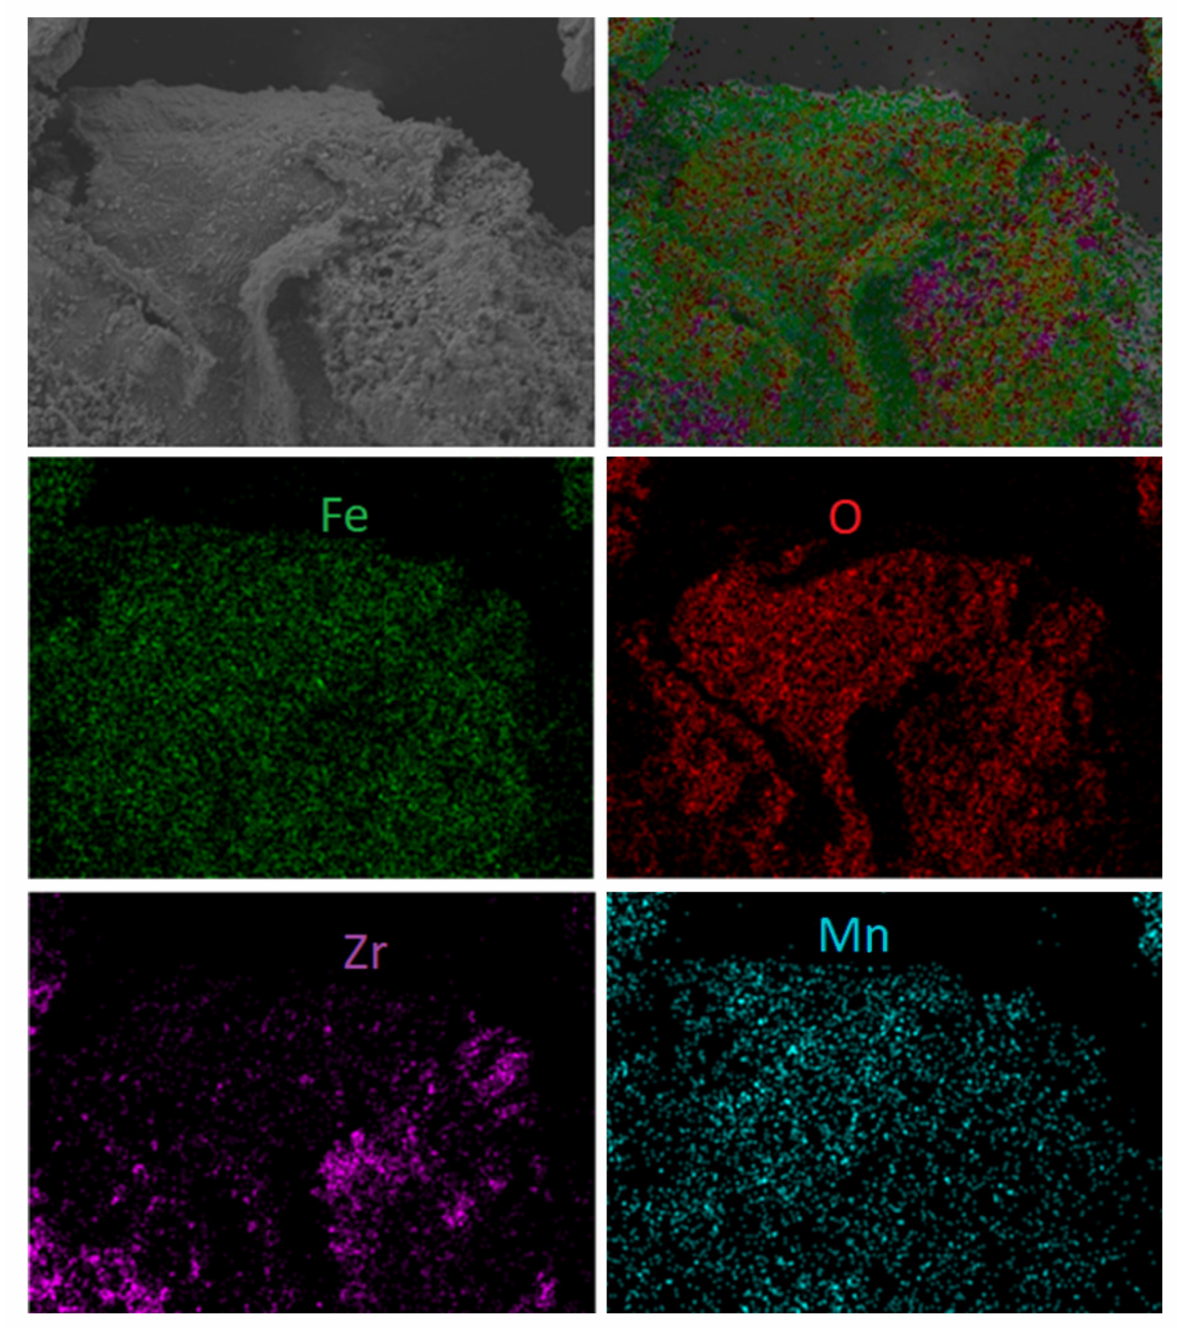
Figure 11. Scanning electron microscope photomicrographs with element mapping for reacted and regenerated F65Mn15